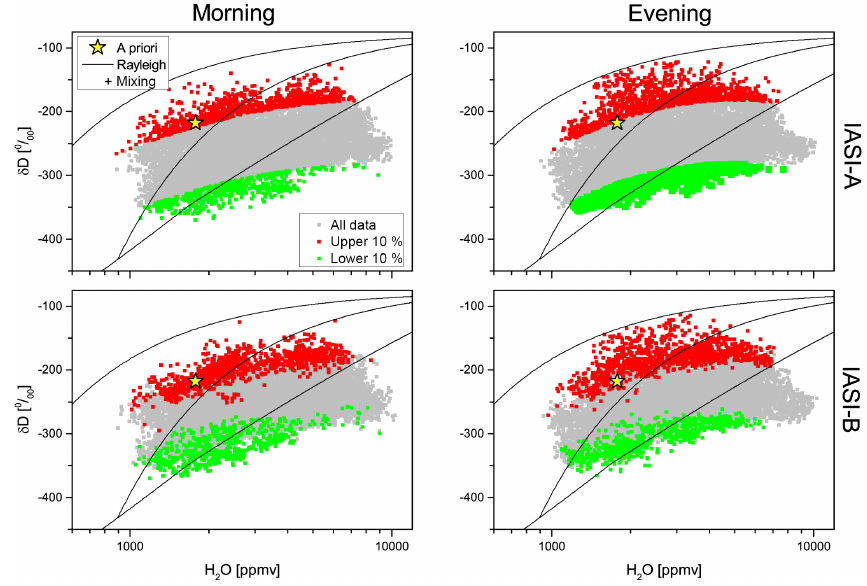
Figure 7. Similar to Fig. 6 but for coincidences of IASI-A and IASI-B measurements. The products retrieved at 4.9km for all coincidences within 1h and 0.25 ◦ × 0.25 ◦ are presented for 16 August 2014. The left panels show the morning overpasses and right panels the evening overpasses. The anomalies are identified in the IASI-A observations (upper panels) and then checked in the IASI-B observations (bottom